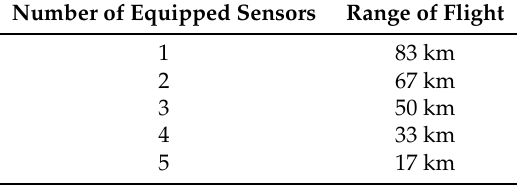
Table 1. Decrease of the UAV range of flight based on the number of equipped sensors used in the Real-World-Inspired Scenario.